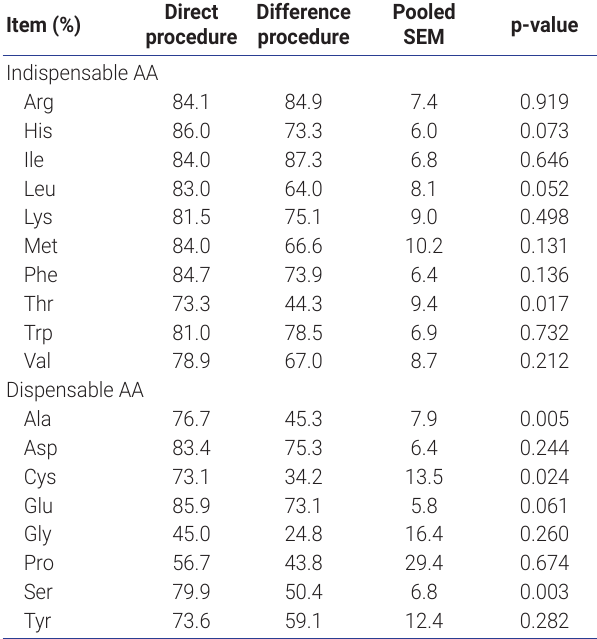
Table 5. Basal endogenous losses of amino acids of nursery pigs fed an N-free diet